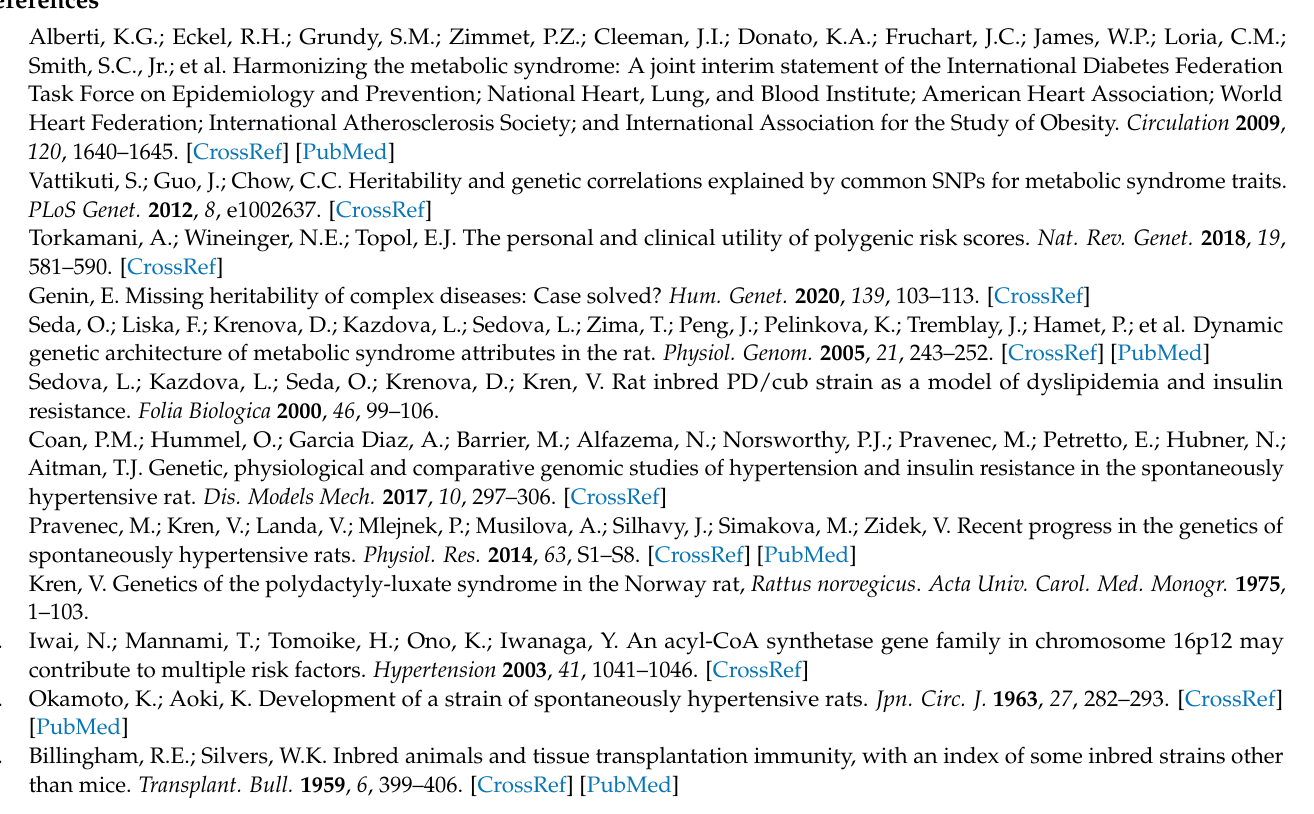
sequencing, Table S3: Cholesterol concentration in lipoprotein fractions, Table S4: Serum concen- tration of selected hormones, Table S5: Serum concentration of selected cytokines, Table S6: List of differentially expressed